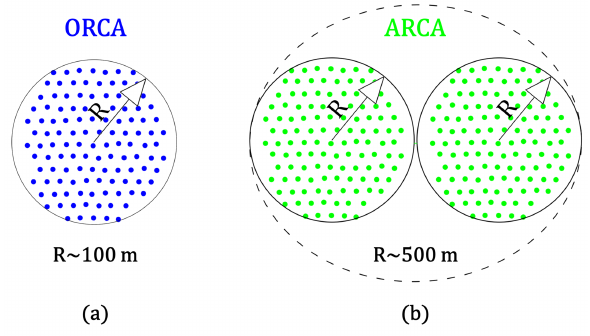
Figure 2. Footprint of KM3NeT at the sea bed. ( a ) The block of Oscillation Research with Cosmics in the Abyss (ORCA) has a radius of about 100 m and has 115 DUs. ( b ) ARCA is composed of two blocks of 115 DUs, each with a radius of about 500